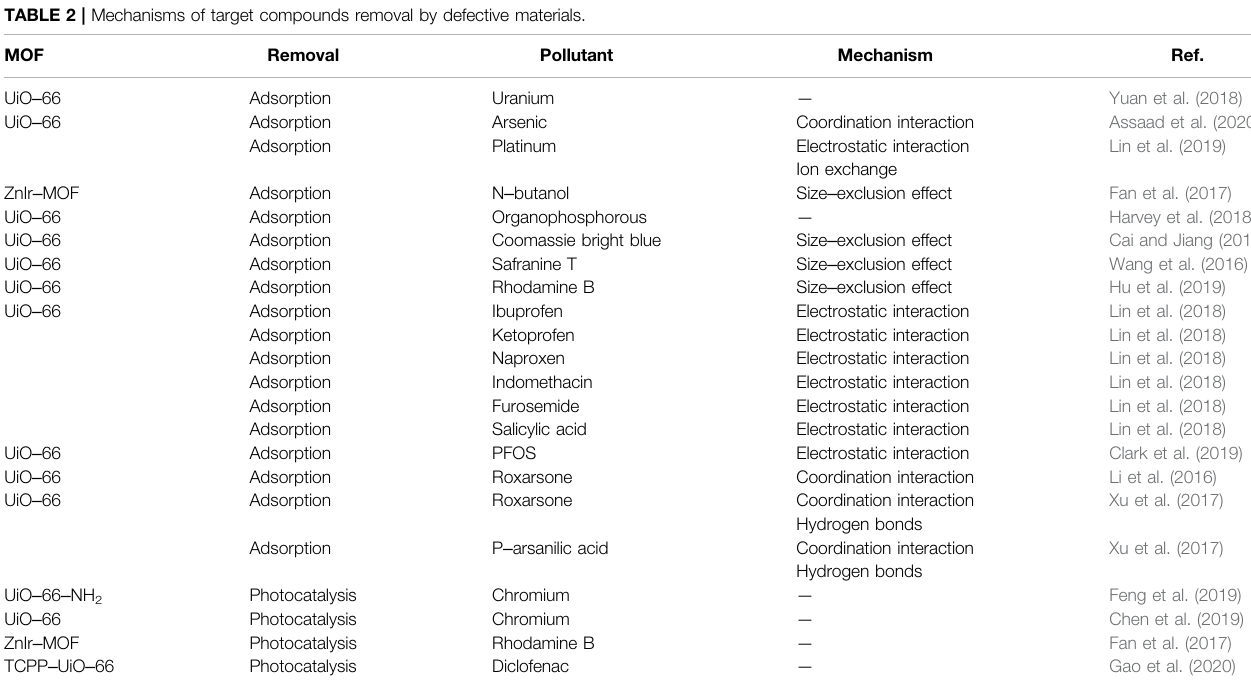
TABLE 2 | Mechanisms of target compounds removal by defective materials. MOF